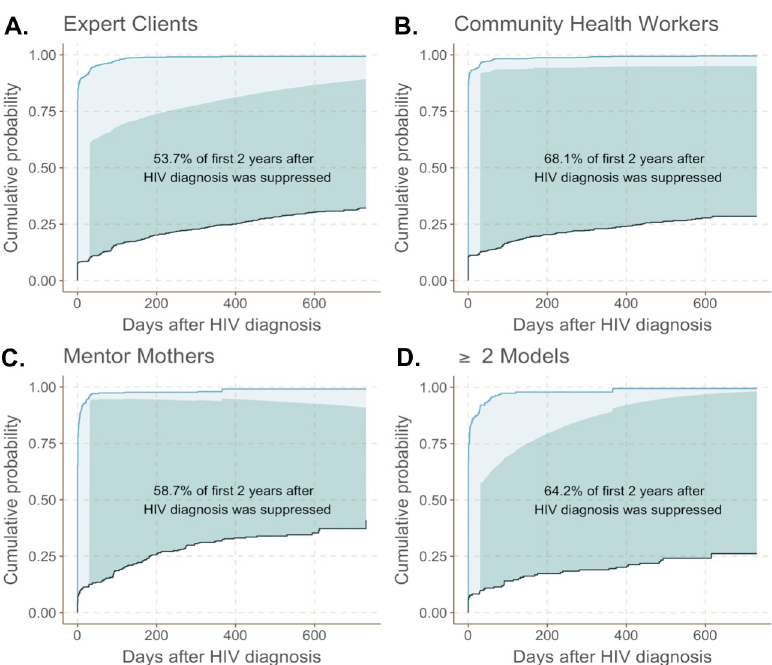
Fig 3. Comparative evaluation of longitudinal maternal virological suppression under 4 different CFL models ( N = 2,049). Each panel presents, by CFL model type, the cumulative incidence of ART initiation (blue curves), LTFU (black curves), number of days on ART (total shaded area), and number of days with virological suppression (dark shaded area), weighted to account for sampling variation across districts and confounding by health facility level. The first 30 days after HIV diagnosis was not included in estimates of number of days with virological suppression. (A)